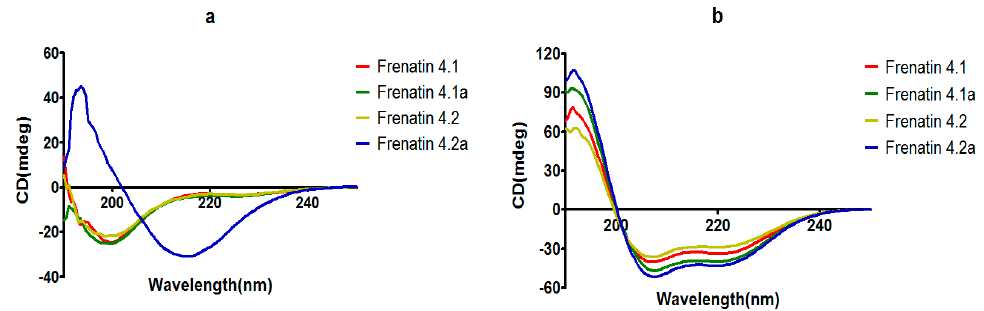
Figure 4. CD spectra recorded for frenatins and their analogues (100 μ M) in ( a ) in 10 mM ammonium acetate water solution and ( b ) in 50% 2,2,2-trifluoroethanol (TFE)/10 mM ammonium acetate water solution.